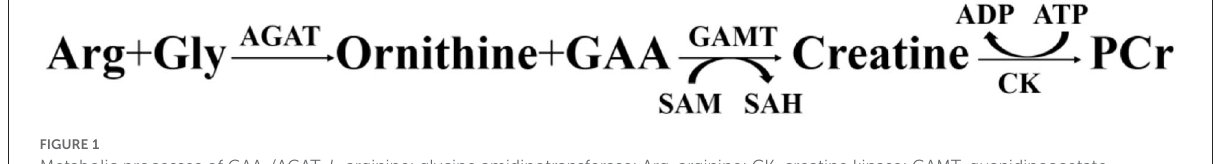
FIGURE1 Metabolic processes of GAA. (AGAT, L -arginine: glycine amidinotransferase; Arg, arginine; CK, creatine kinase; GAMT, guanidinoacetate N-methyltransferase; Gly, glycine; SAH, S-Adenosine homocysteine; SAM, S-Adenosylmethionine; PCr, phosphocreatine).